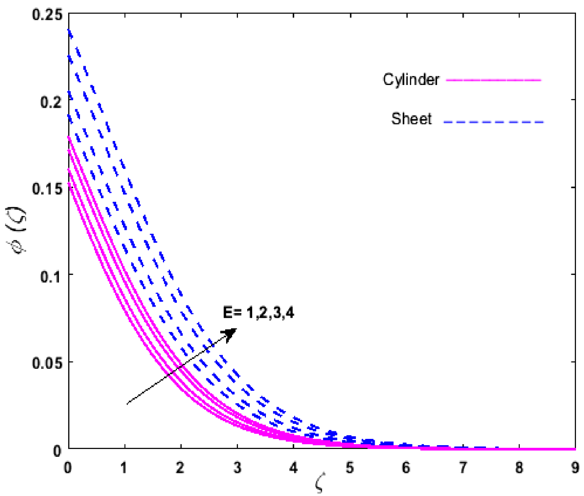
Figure 17. Upshot of E on φ(ζ)